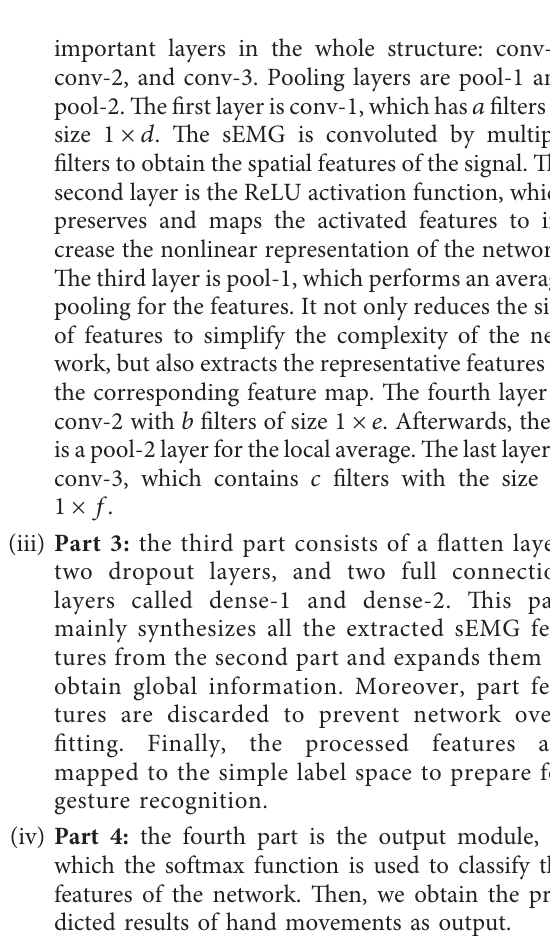
Figure 1: The proposed network architecture for sEMG recognition. The original sEMG is sequentially fed to LWCNN for feature extraction to obtain corresponding feature maps, which has been preprocessed by filtering and denoising. The feature map is then flattened into feature vectors to the fully connected layer for preliminary identification. To better represent different gesture feature, the PSO model is adopted